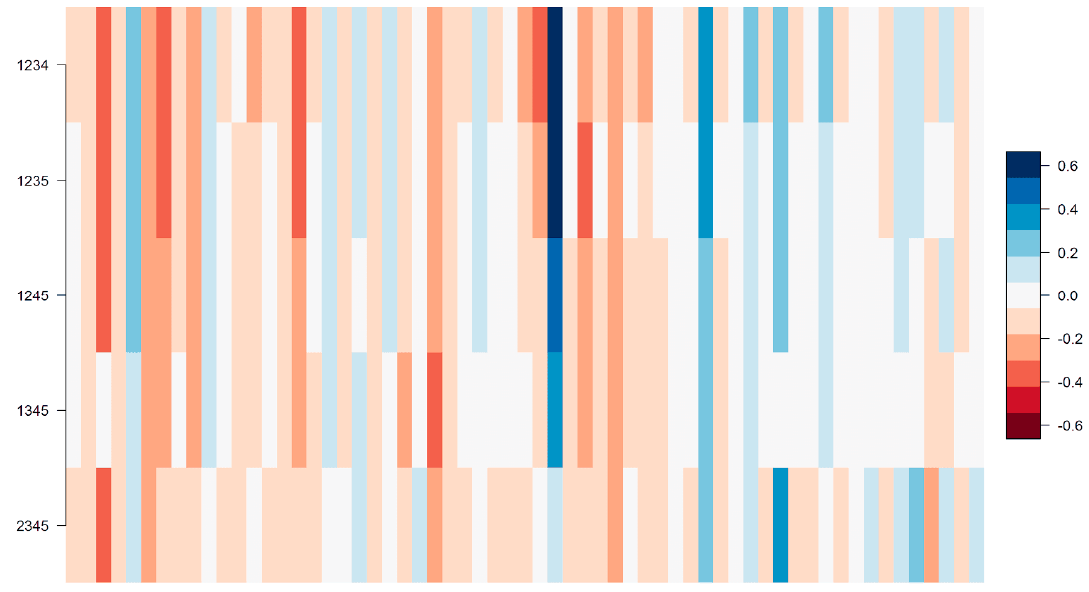
Figure 4. Heat map of the regression weights for the final model of phage P4/6409. Columns are gene families, rows are cross validation folds. The color indicates the value and direction of each weight, with blue being strongly positive and red being strongly negative. Weights with low values are white. Results were comparable for other phages with the exception of 1N/80, A3/R, and mix MS-1 (see Table 2).